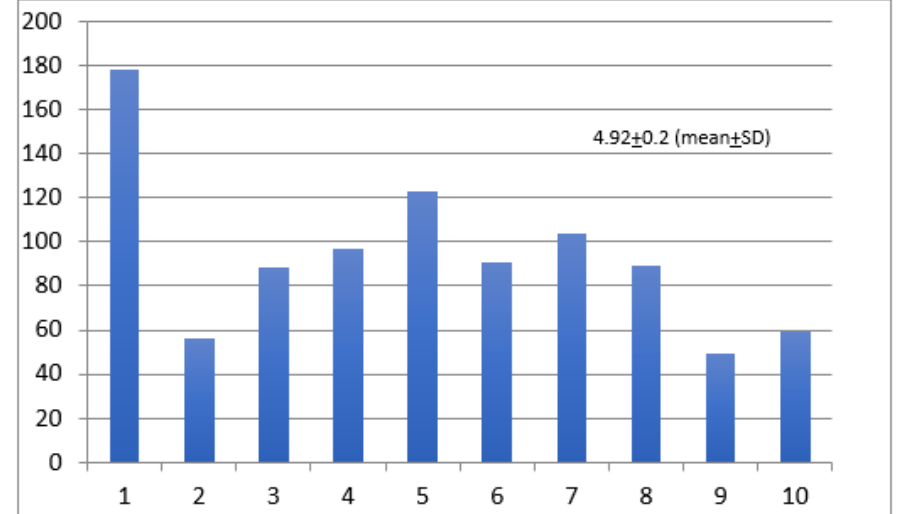
Figure 3. Institutional support with human resources. Likert Scale: 1 = no access to resources, 10 = full access to resources. Y -axis = number of responders.